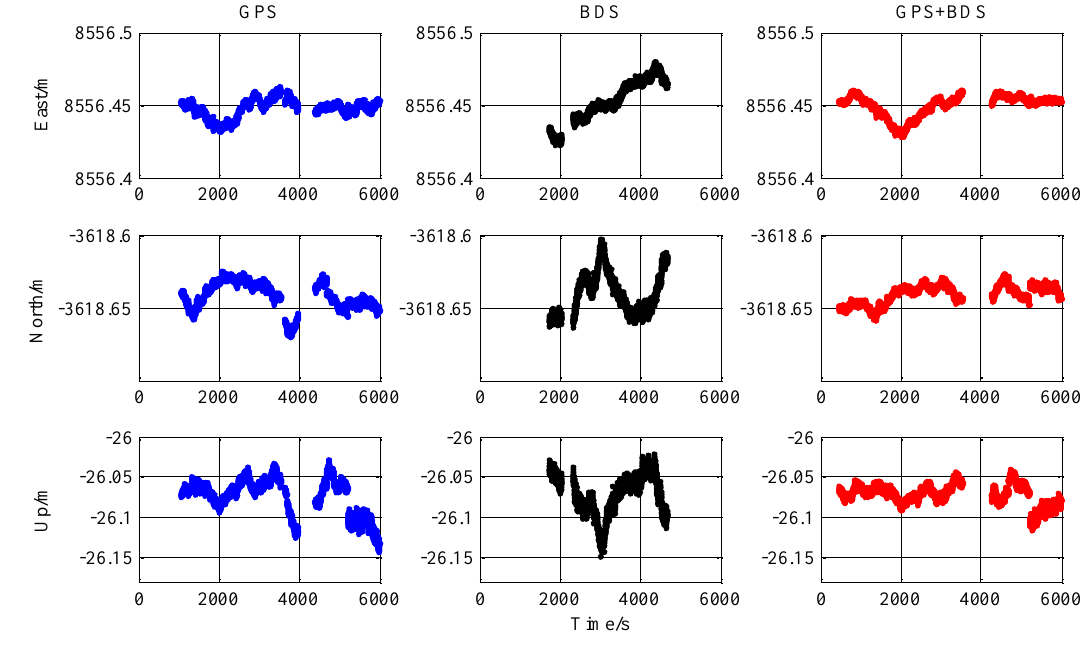
Figure 11. Number of available satellites and ratio vs time of 9 km baseline experiment.